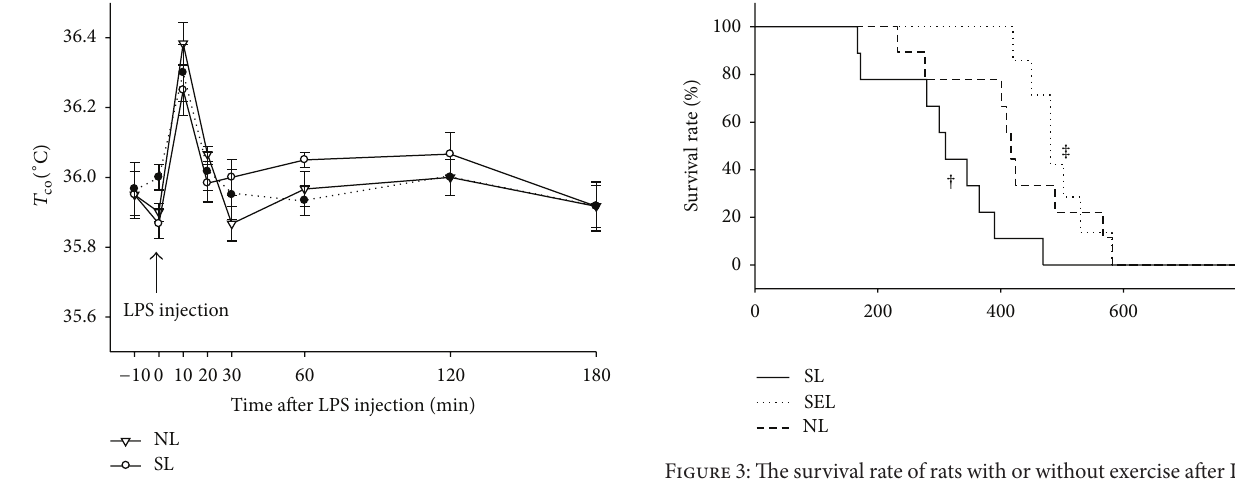
Figure 3: The survival rate of rats with or without exercise after LPS administration (15mg/kg, i.v.). NL: nondiabetic rats receiving LPS administration; SL: STZ-induced diabetic rats injected with LPS; Figure 2: The colonic temperature ( 𝑇 ) of the animals in response co SEL: STZ-induced diabetic rats with exercise injected with LPS ( 𝑛 = toLPSchallenge.NL:nondiabeticratsreceivingLPSadministration; 8 per group). † 𝑃 < 0.05 , compared with the NL group; ‡ 𝑃 < 0.05 , SL: STZ-induced diabetic rats injected with LPS; SEL: STZ-induced compared with the SL group (Kaplan-Meier diabetic rats with exercise injected with LPS ( 𝑛 = 8 per group).